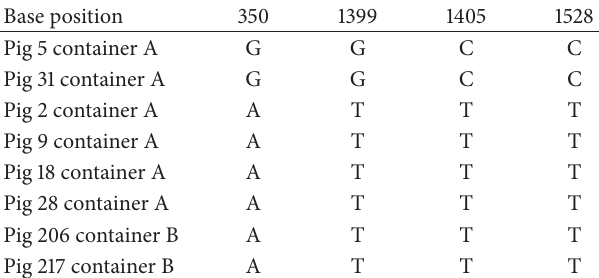
Table 5: Position of base differences identified in the full PCV2 genomes isolated from pigs from containers A and